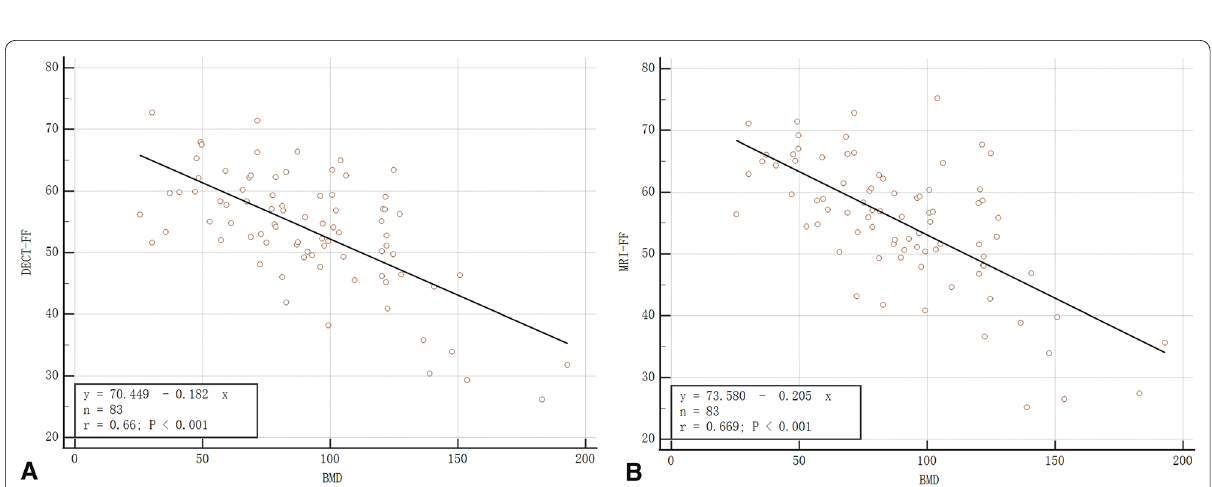
Fig. 5 Correlation between DECT-FF, MRI-FF, and BMD. A , B DECT-FF and MRI-FF were correlated with BMD, with R-values of respectively. DECT Dual-energy computed tomography, MRI magnetic resonance imaging, FF fat fraction, BMD bone mineral